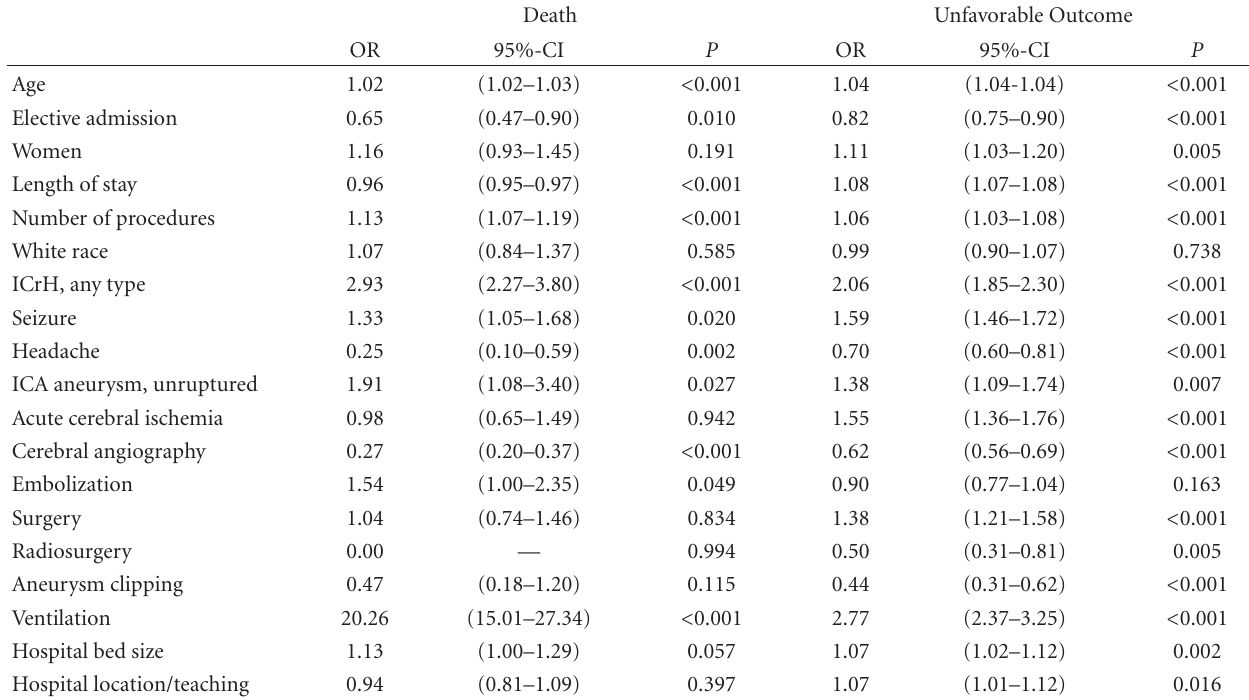
Table 2: Risk of Death and Unfavorable Outcome ∗